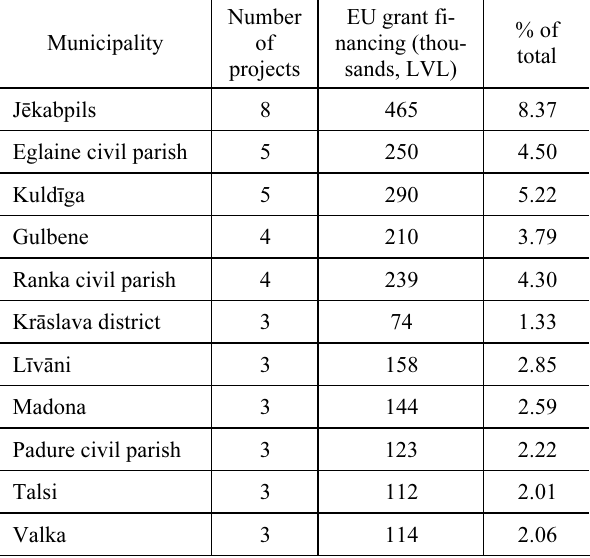
Table 6. Distribution of contracts concluded for